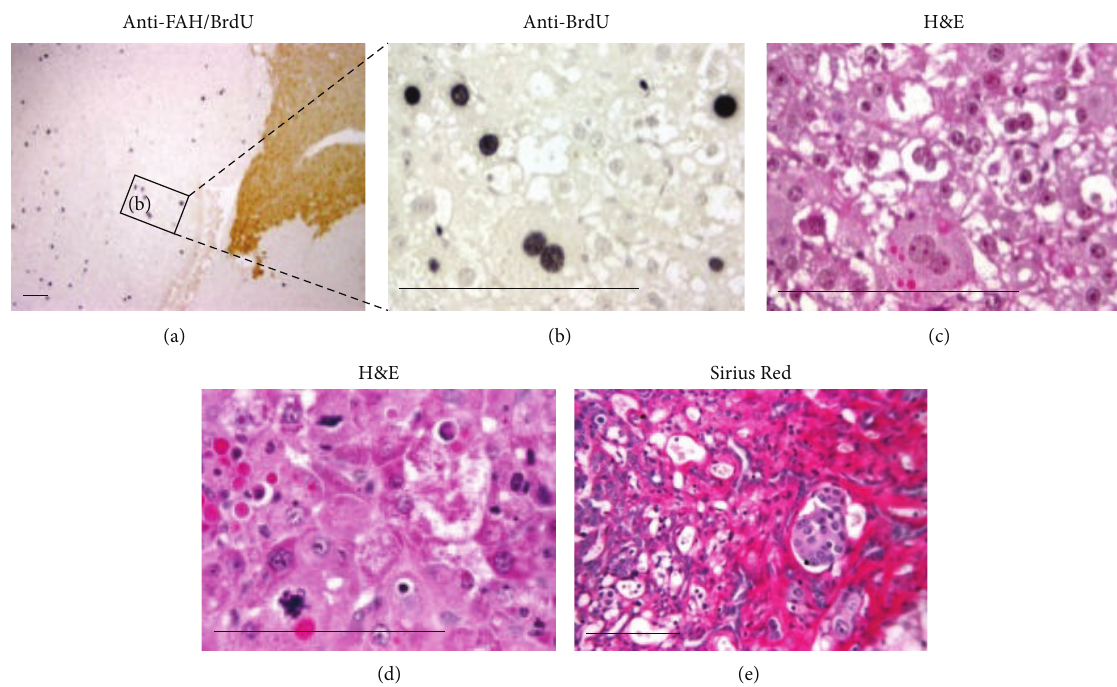
Figure 5: Histochemical characteristic of liver tumors. Liver sections from a 32-week mouse after BMT were stained for Fah (brown) and BrdU (dark nuclei) by immunohistochemistry to indicate the region of Fah + nodules with BrdU uptake (a). The higher power view of the indicated region shows a Fah − tumor with significant BrdU uptake in (b). Sections were also stained with hematoxylin and eosin to identify malignant cells (c and d) and Sirius Red to detect collagen (e). Sections (b) and (c) were serial sections and vascular invasion was also observed in (e). Scale bars are 100 𝜇